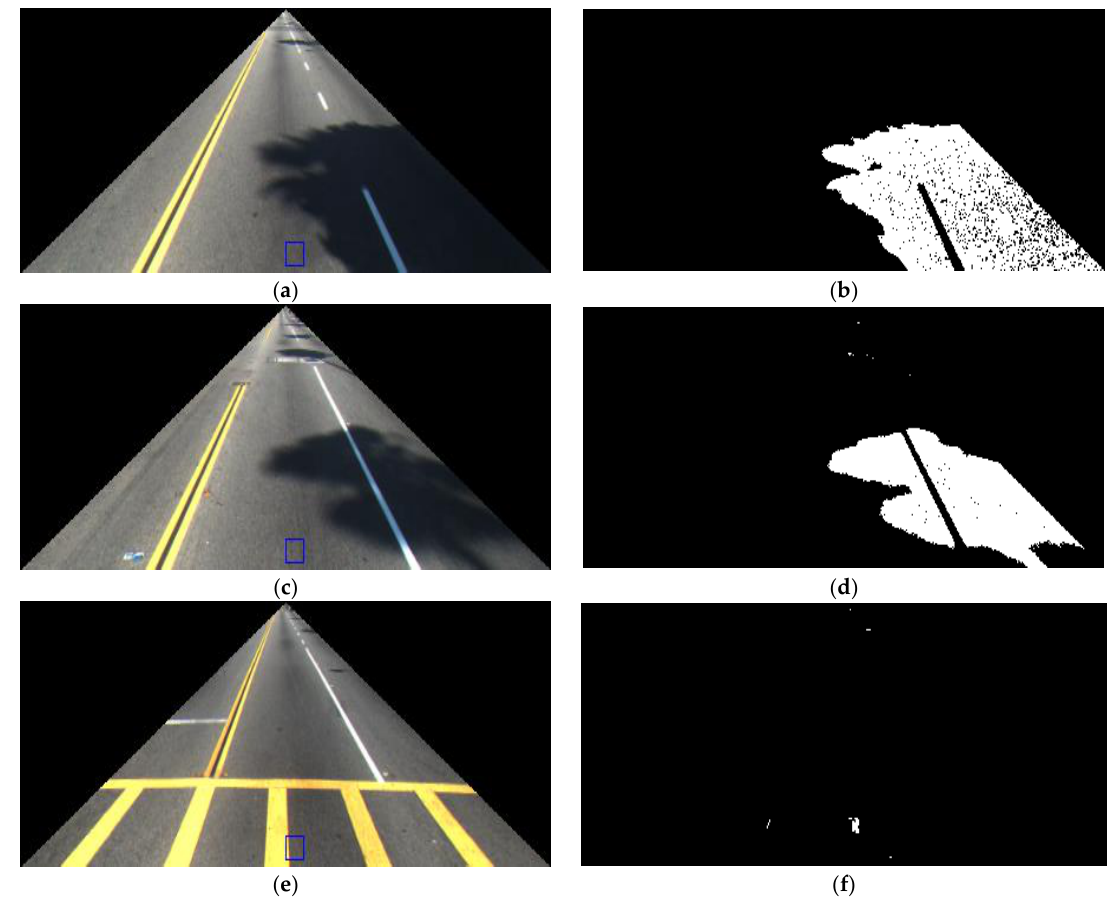
Figure 6. Examples of extracted shadows for calculating feature 1. Background ROI ( B ) of Equations (4)–(6) and Figure 5 is shown by the blue box in Figure 6a,c,e: ( a , c , e ) Image in the ROI; ( b , d , f ) binarization image of detected shadow by Figure 5.